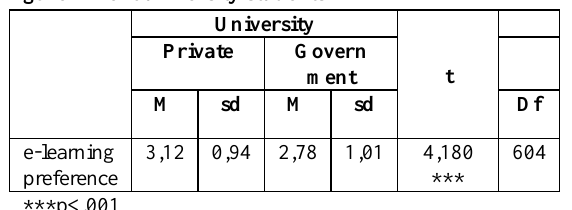
Table 3: e-learning preference scores of private and